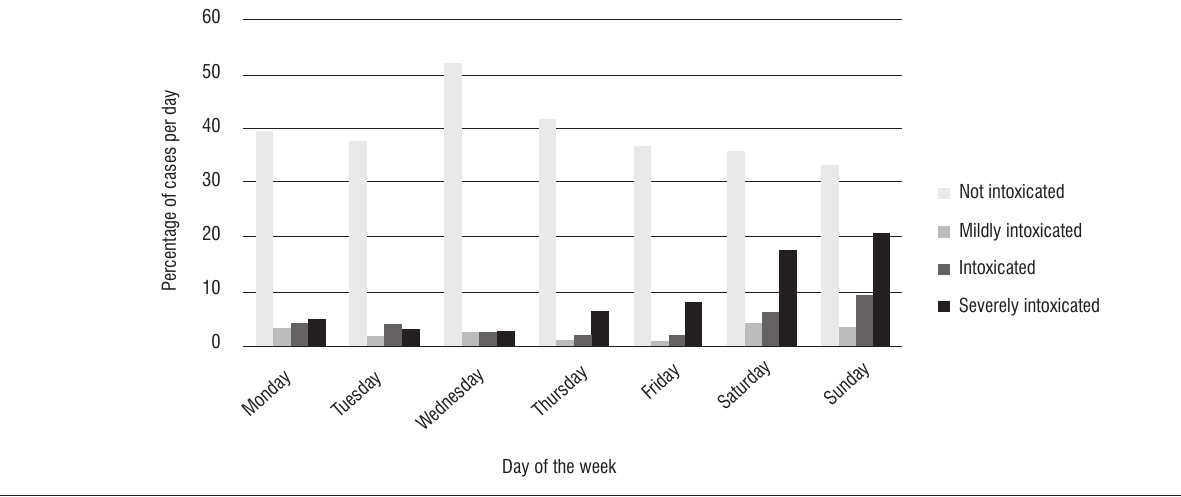
Figure 4: Percentage distribution of intoxication levels during the week as a percentage of the total blunt force trauma homicide cases per day from 2010 to 2014.